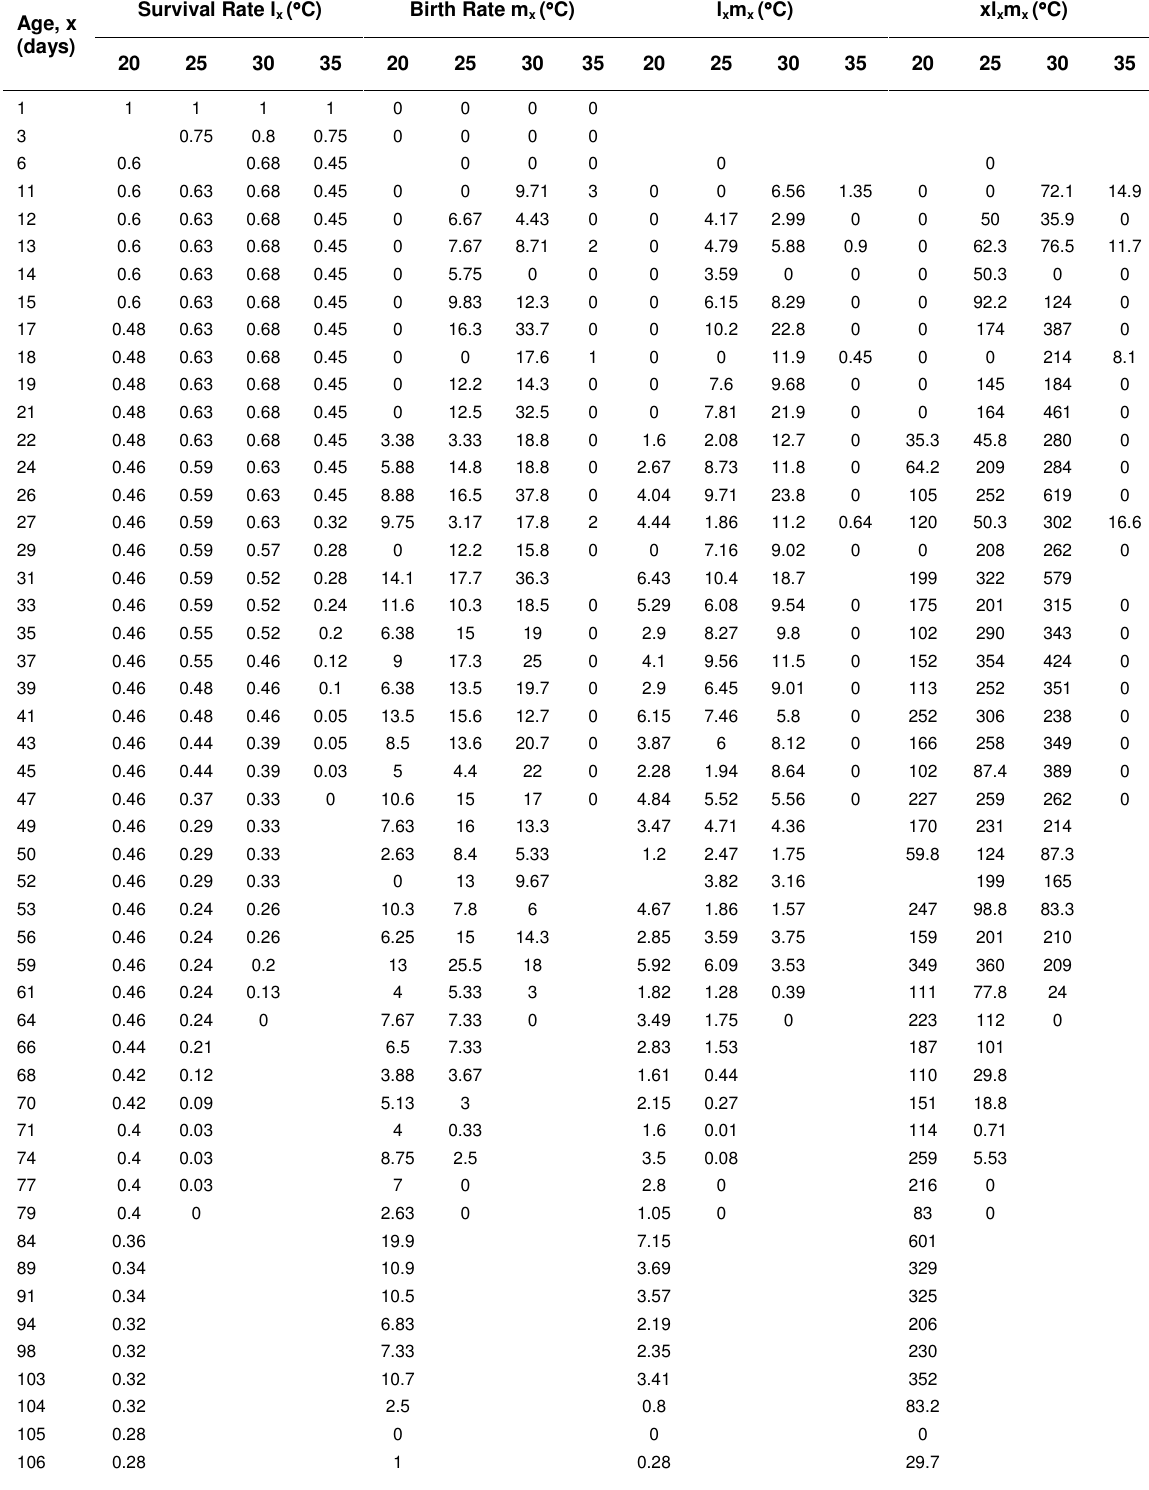
Fecundity Life Table for P. dubia at Different